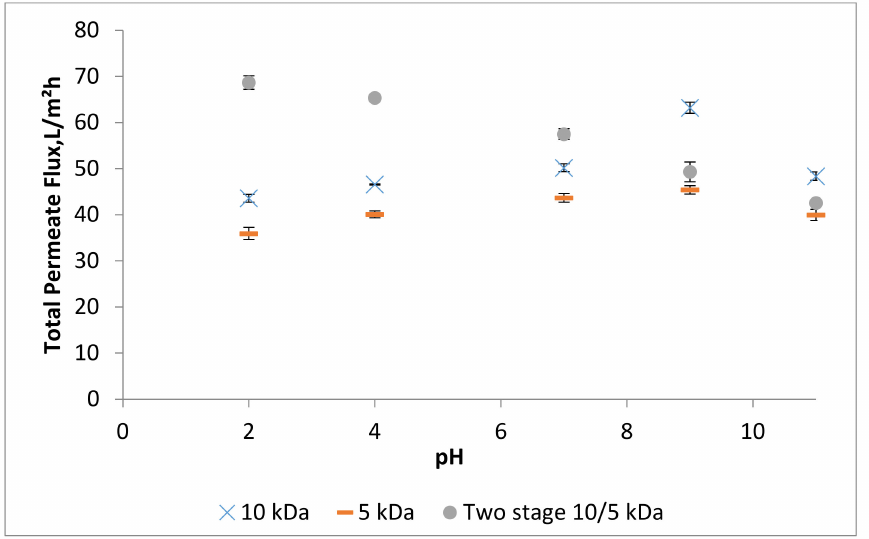
Figure 7. Total permeate flux at different pH for single and two stage UF